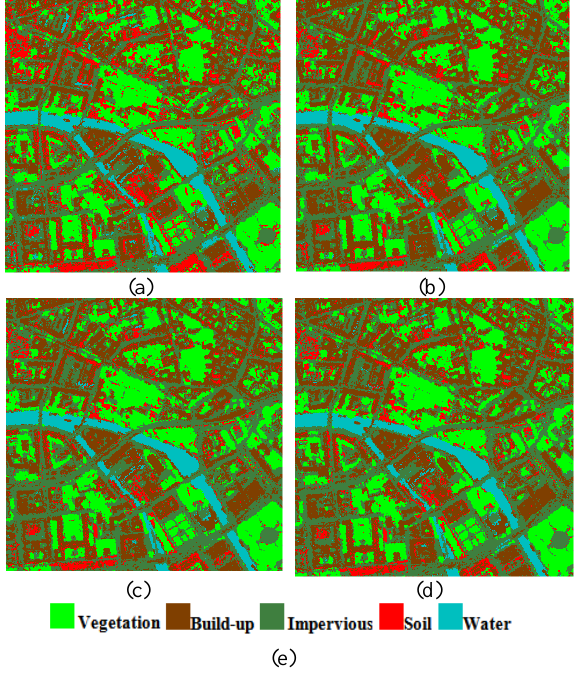
Figure 2. Berlin dataset: (a) SVM Classification map, (b) MMSF Classification map, (c) MSF-SVM Classification map (d) reference map and (e) the legend.